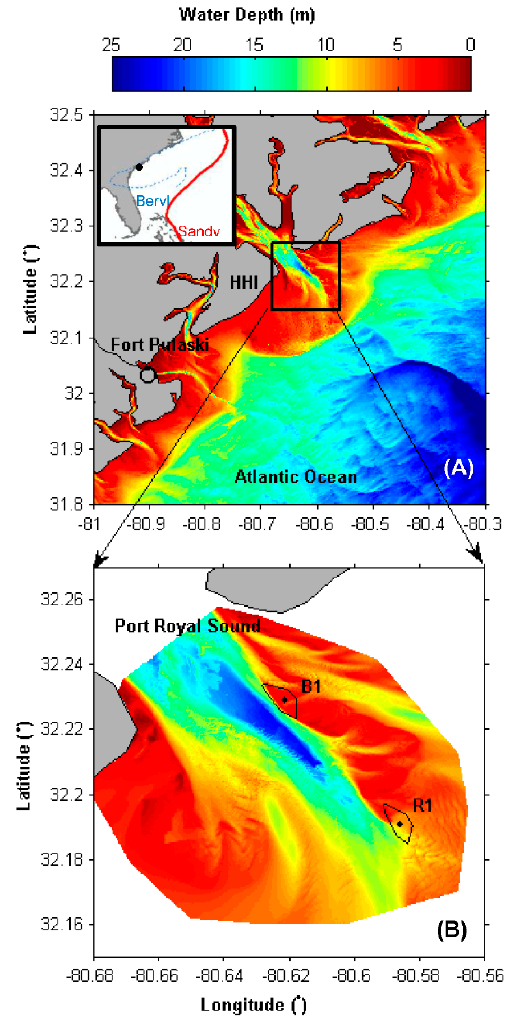
Figure 1. The study area of Port Royal Sound in South Carolina. ( A ) Bathymetry data of upper panel are downloaded from National Oceanic and Atmospheric Administration’s National Geophysical Data Center (NGDC). The inset in ( A ) shows the South Atlantic Bight, the study area (black dot), and track lines of Tropical Storm Beryl (blue) and Hurricane Sandy (red). ( B ) Bathymetry data of the lower panel are provided by Olsen Associate. Borrow site B1 and reference site R1 are two quadrapod locations in this study. Fort Pulaski is wind station maintained by the National Data Buoy Center.